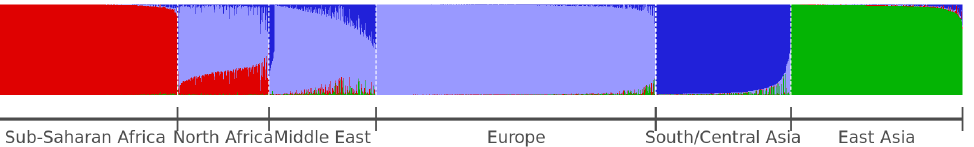
Figure 2. Barplots of the STRUCTURE admixture components ( K = 4) for the reference samples from six metapopulations. There is a clear visual difference between the admixture components for the six